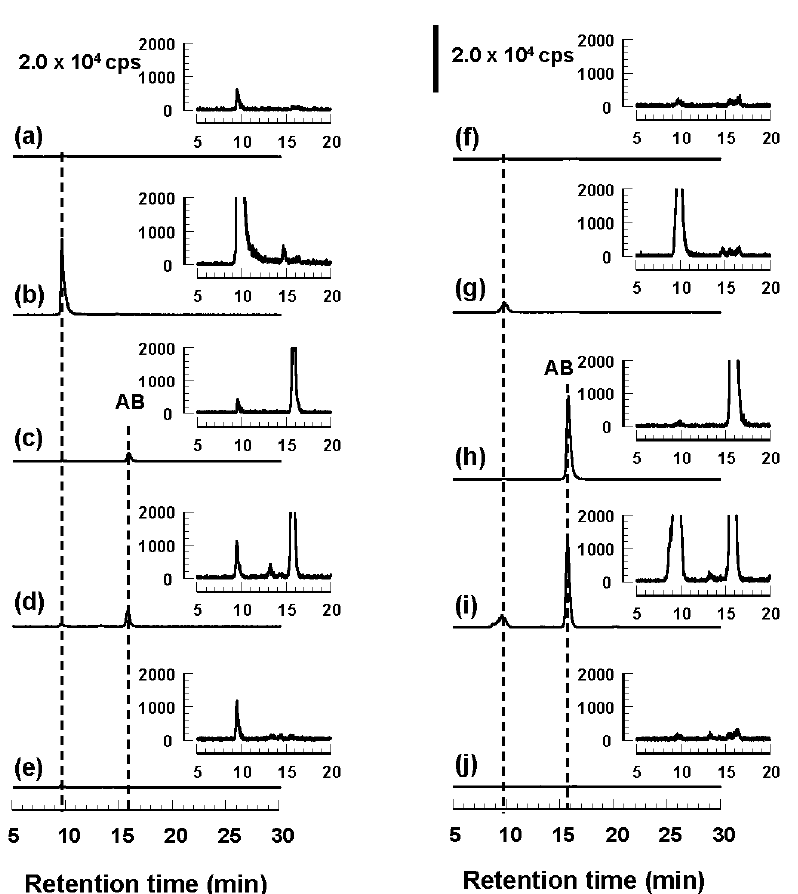
Figure 4. Elution profiles of arsenic in ( a – e ) RBC lysate or ( f – j ) plasma in rats after oral administration of: ( a , f ) deionized ‐ distilled water (control); ( b , g ) DMA V ; ( c , h ) AB; ( d , j ) AC; and ( e , j ) TMAO V . Samples were subjected to gel filtration and assayed by HPLC ‐ ICP ‐ MS. A 20 ‐μ L sample was applied to the column, which was eluted with the pre ‐ filtered (0.22 μ m) mobile phase; see Table 1 for the elution conditions.